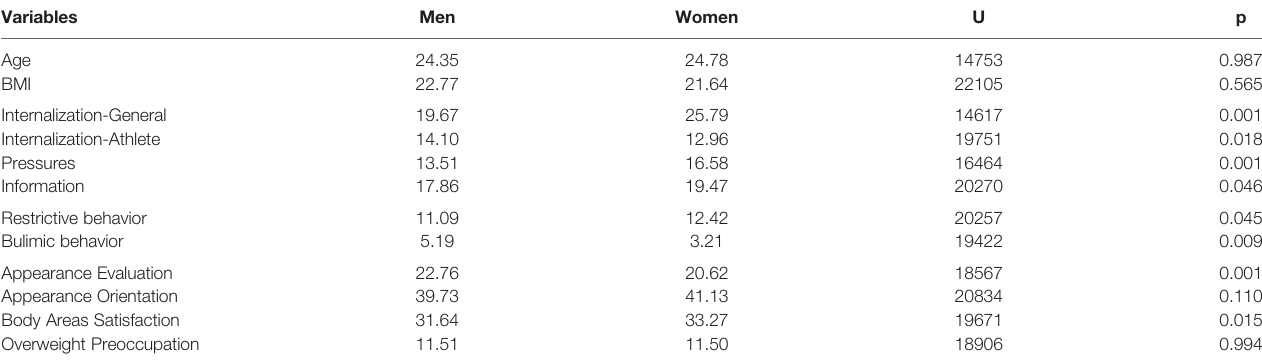
TABLE 4 | Characteristics of differences in mean values in terms of variable values in men (N=116) and women (N=398). Variables Men